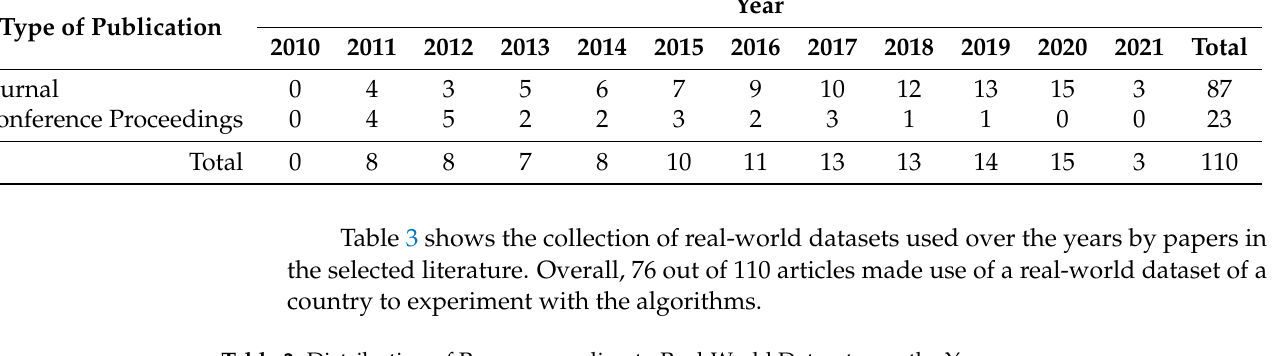
Table 3. Distribution of Papers according to Real-World Dataset over the